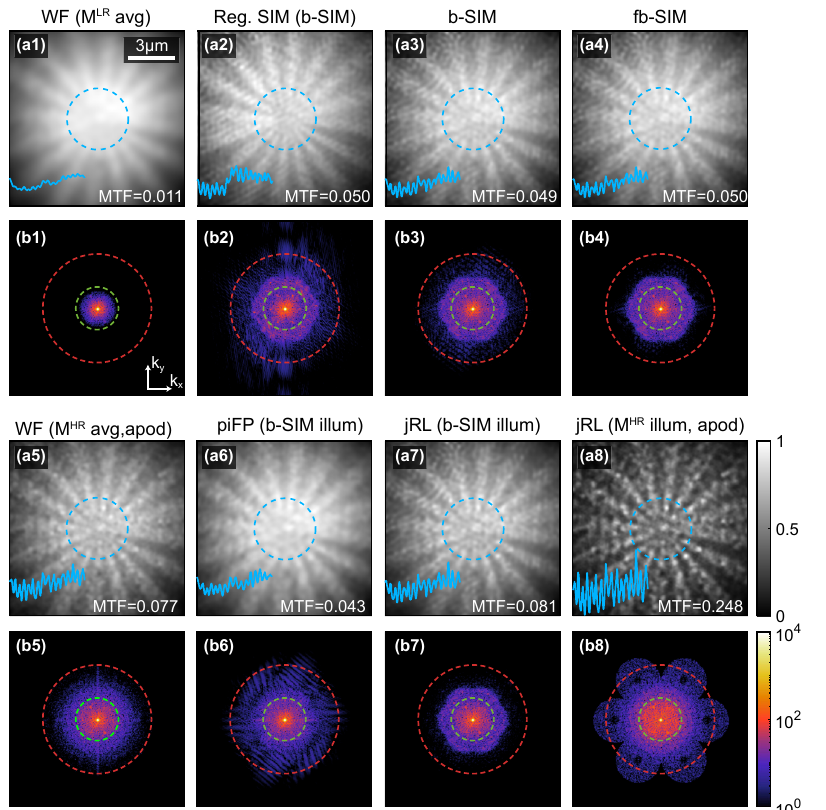
Figure 7: Experimental double moiré localized plasmon SIM (DM-LPSIM) results. (a1) WF image calculated by averaging over the LR DM-LPSIM data set. (a2) b-SIM reconstruction using regular SIM illumination. (a3,a4) b-SIM and fb-SIM DM-LPSIM reconstructions. (a5) High- resolution WF image calculated by averaging over the HR DM-LPSIM data set. (a6,a7) piFP and jRL DM-LPSIM reconstructions using illuminations reconstructed with b-SIM. (a8) jRL reconstruction, which used the HR DM-LPSIM data set as illumination and was apodized with the Fourier filter shown in Figure 8(c). Each of the insets in panels (a1) – (a8) shows a cross-cut along the blue dashed circle. The accompanying modulation transfer function (MTF) values were obtained through a sine fi t to these cross-cuts.(b1 – b8)2DFouriertransformsof (a1 – a8). The green dashed circles indicate and the red dashed circles k HR . (a2) k LR cutoff cutoff uses a regular SIM data set, while all the other panels use the same DM-LPSIM data set. Both data sets were recorded with 300 ms exposure time.